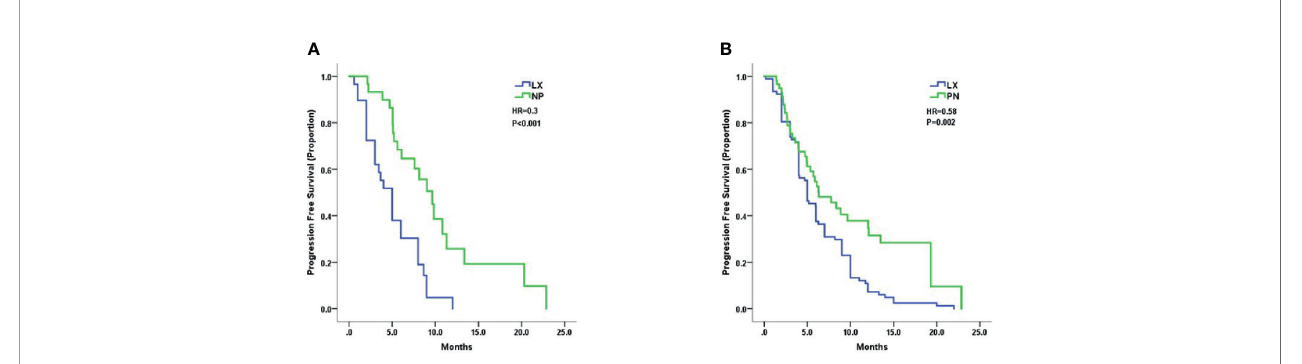
FIGURE 2 | Kaplan – Meier curves for progression-free survival by treatment arm for patients with: (A) trastuzumab resistance and (B) trastuzumab refractoriness.